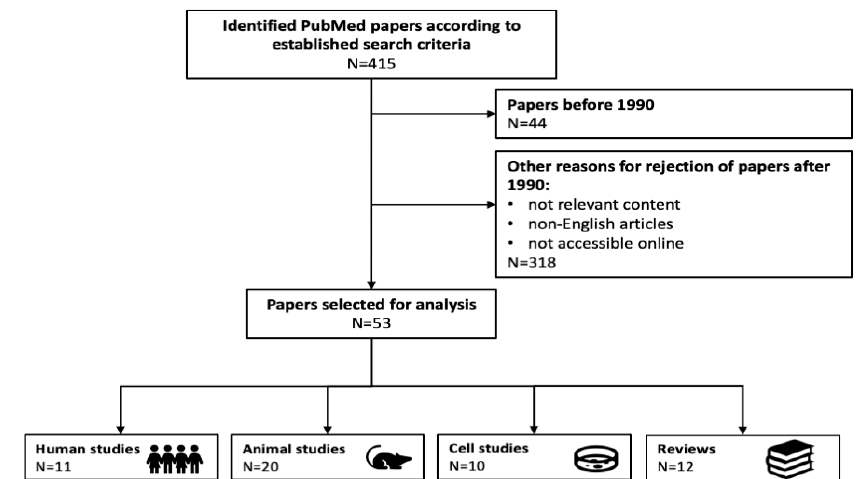
Figure 1. Flowchart illustrating selection criteria for analyzed papers. In total, there were 53 papers selected for the analysis.